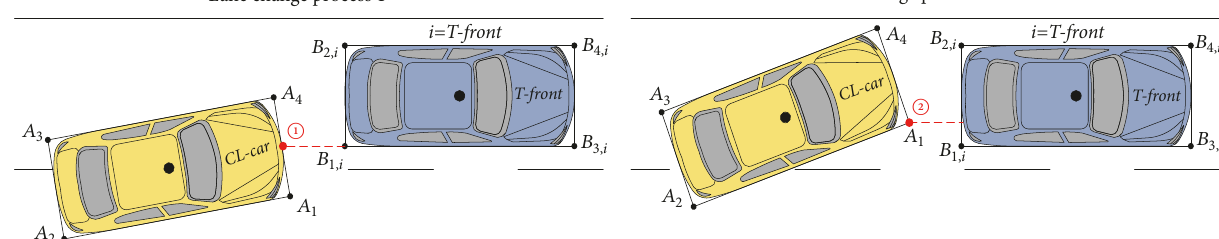
Figure 9: Potential angle collision point positions in different lane change processes between CL-car and T-front .